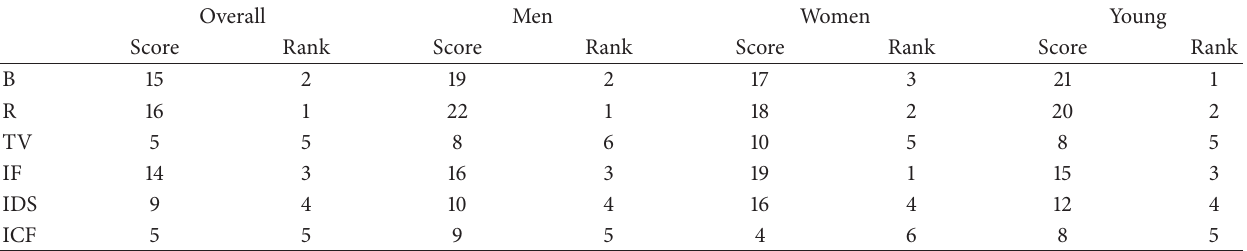
Table 5: Scoring and ranking of proposed alternative activities by the groups